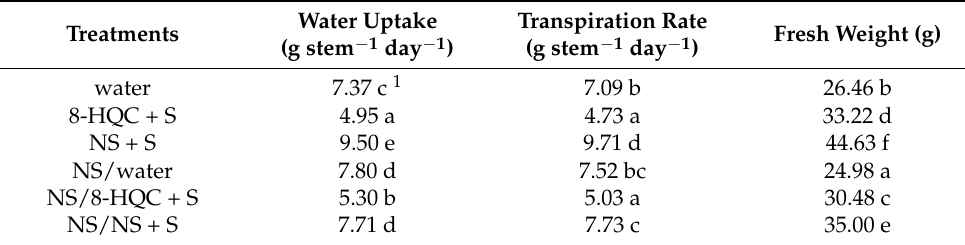
Table 2. The effect of preservatives on the water balance parameters in cut lisianthus ‘Mariachi Blue’